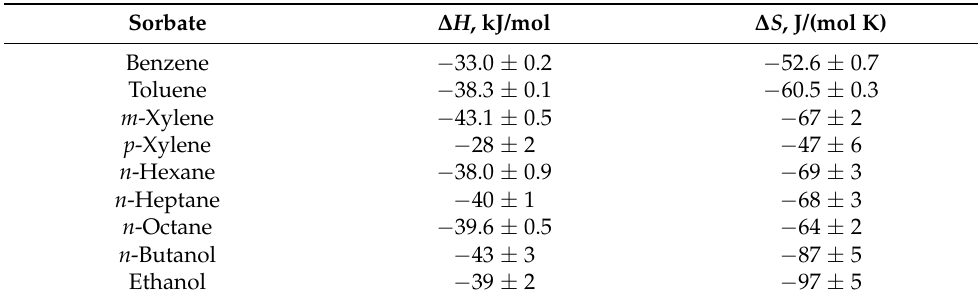
Table 3. Thermodynamic parameters of sorption of hydrocarbons and alcohols in PTBSN after the second stage of heating (200 ◦ C).